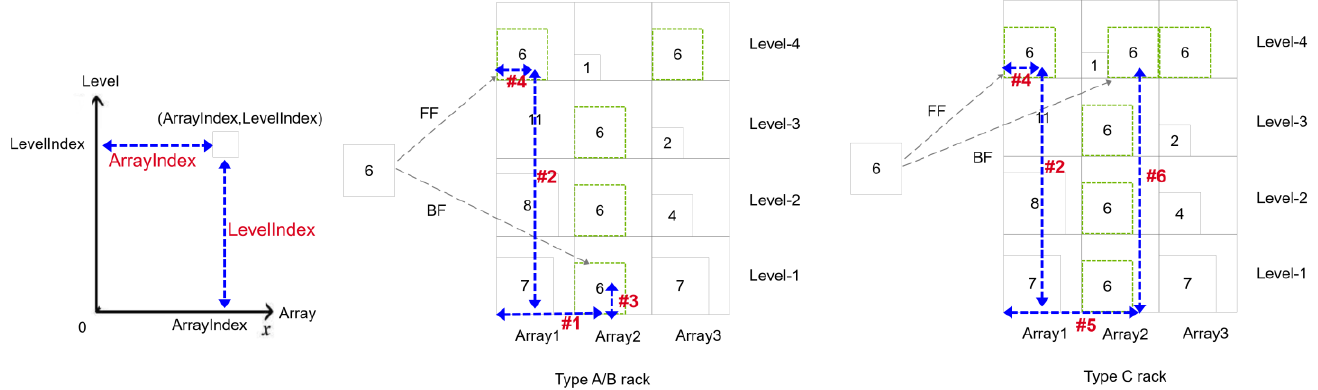
Figure 6. T he BF and FF method in Type A/B/C models. Figure 6. The BF and FF method in Type A/B/C